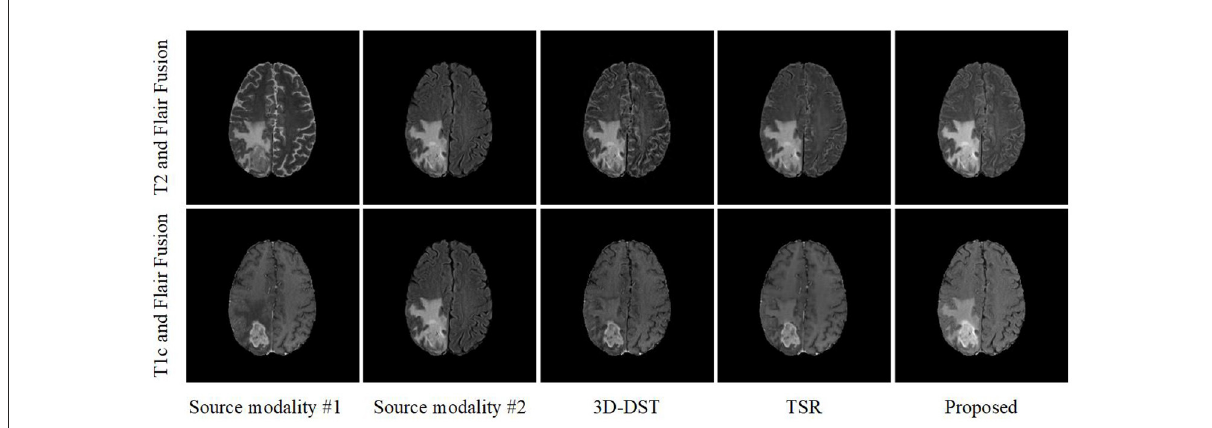
FIGURE4 An example of fusion results obtained by different 3D medical image fusion methods.